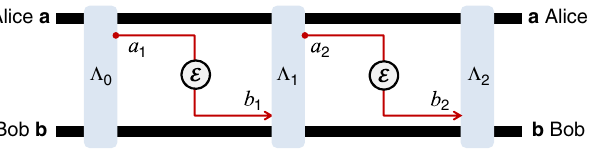
Figure 1 | Adaptive quantum protocol. The first step is the preparation of of a and b by some adaptive LOCC L 0 . the initial separable state r 0 ab